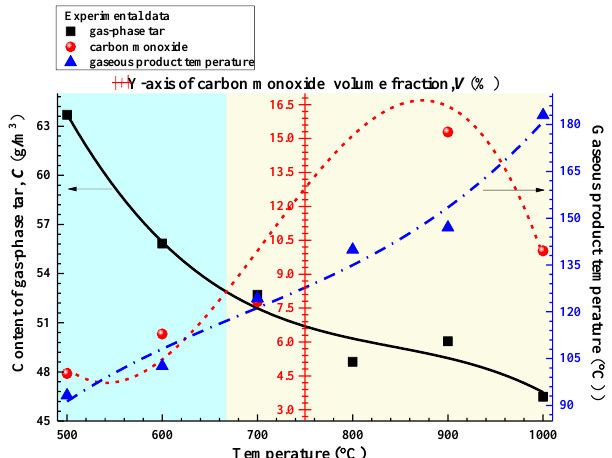
Figure 14. Variation of gas-phase tar content, CO volume fraction, and gaseous product temperature with the pyrolysis temperature under the flow volume ratio of Brown’s gas to nitrogen of 5%. Figure 15 shows the equilibrium relationship between the flow volume ratio of Brown’s gas to nitrogen, gas -phase tar content, gaseous product temperature, and CO volume fraction during the pine wood pyrolysis. Obviously, in order to achieve a lower gas-phase tar content, a higher pyrolysis temperature is required without introduced the Brown’s gas (the flow volume ratio of Brown’s gas to nitrogen is X:N 2 = 0%). Biomass gas- phase tar reaches lower content after primary cracking and secondary cracking, as shown in Figure 15a. With the increasing the volume flow rate of Brown’s gas, a wider selection space is provided for the content balance among the gas-phase tar content, gaseous prod- uct temperature, and CO volume fraction, (see the zone surrounded by solid lines in the Figure 15d – f). Meanwhile, a certain pyrolysis condition of a small gas-phase tar content and a large CO volume fraction can be obtained at the lower pyrolysis temperature, (see the zone enclosed by dotted line in Figure 15f). Therefore, based on the experimental con- ditions in this paper, the minimum gas-phase tar content and the maximum CO volume frac- tion are obtained at the pyrolysis temperature of 800 ° C and the flow volume ratio of Brown’s gas to nitrogen of 5%. This provides some guidance for further pilot scale experiments.